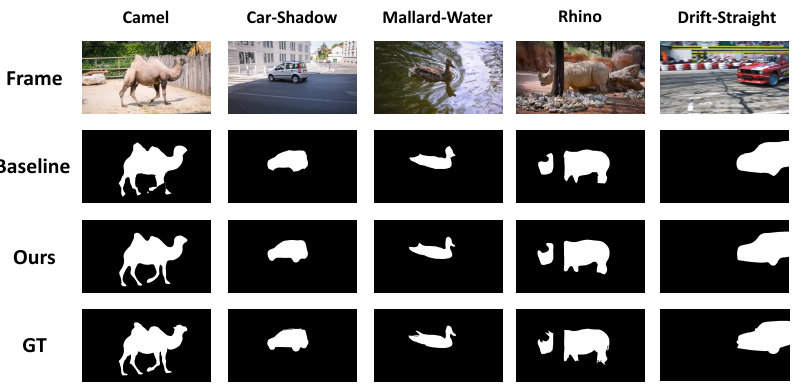
Figure 4. The cases of failure from our network.